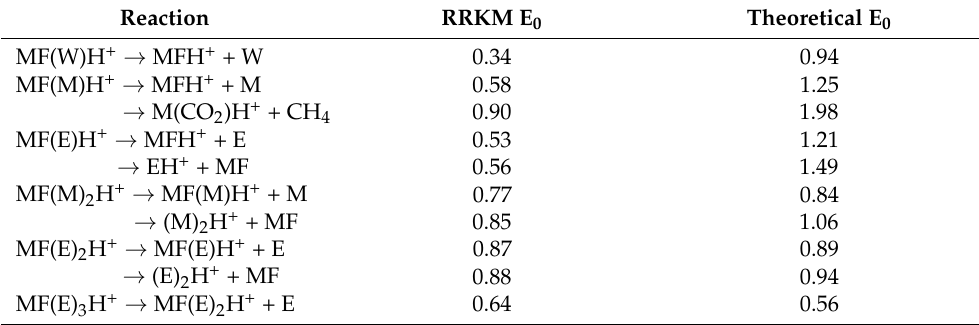
Table 1. Comparison of the RRKM-estimated reaction energies 1 (Figure S3) with those calculated values shown in Figure 2.